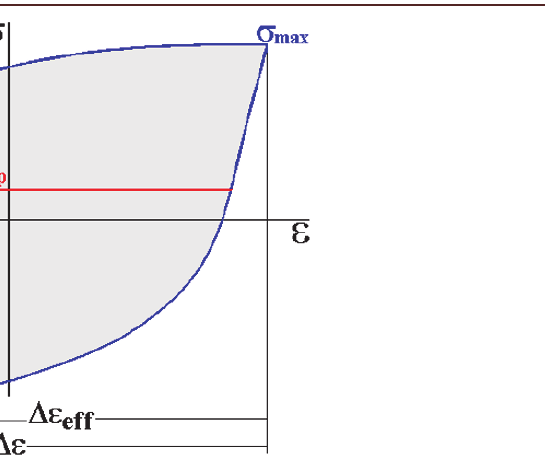
Figure 2: The effective strain range of the hysteresis loop,  eff     op , is the loop portion where the microcrack is completely open, thus can suffer fatigue damage.